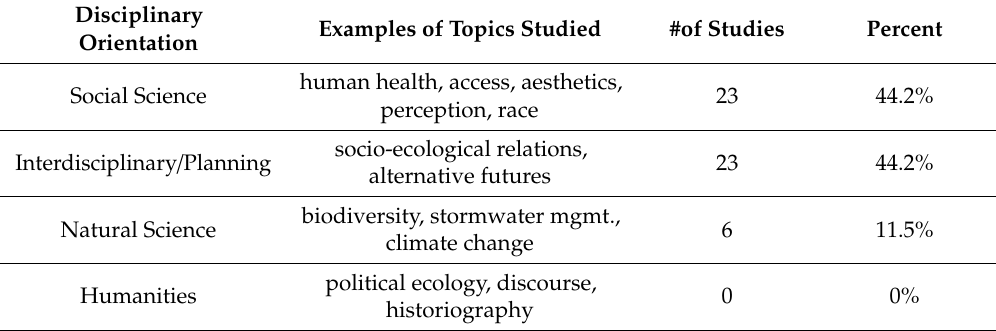
Table 4. Distribution of disciplinary orientation.